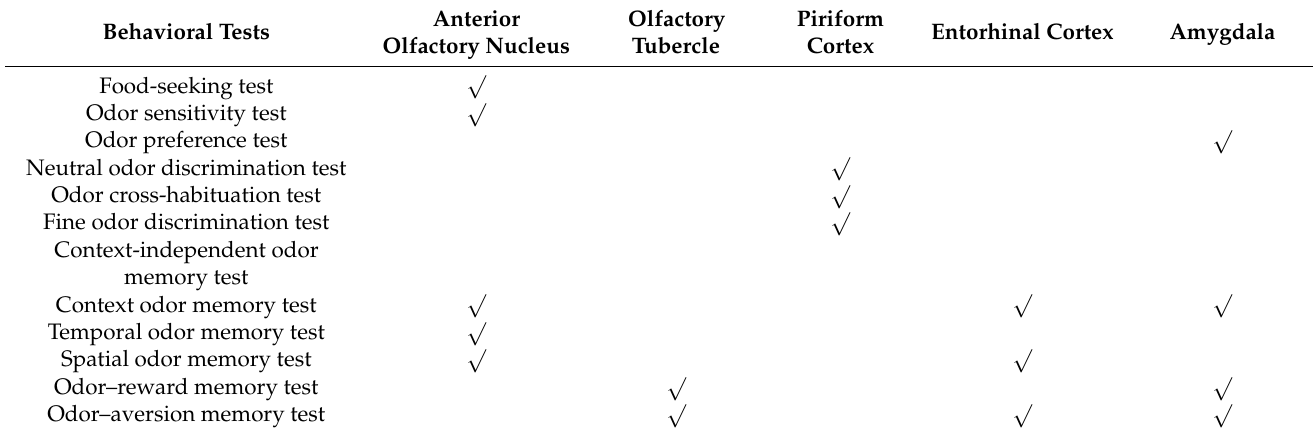
Table 1. Olfactory behavioral summary of olfactory cortex